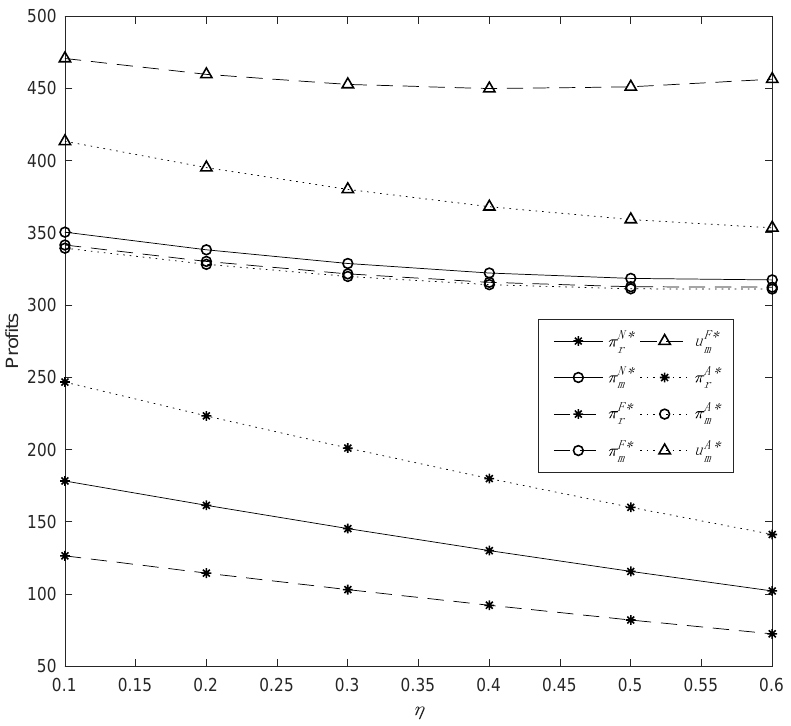
Figure 2. The change in profits with parameter η.